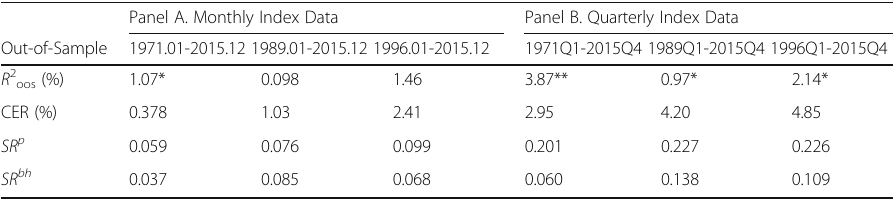
Table 9 Out-of-Sample Forecasting Analysis Panel A. Monthly Index Data Panel B. Quarterly Index